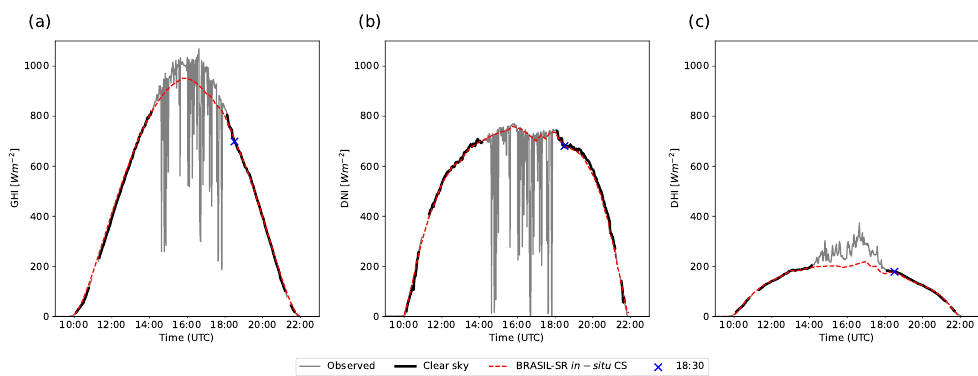
Figure A3. GHI ( a ), DNI ( b ) and DHI ( c ) at ARM_Manacapuru on 19 September 2015. The time of spectral results comparison (18:30 UTC) is indicated.